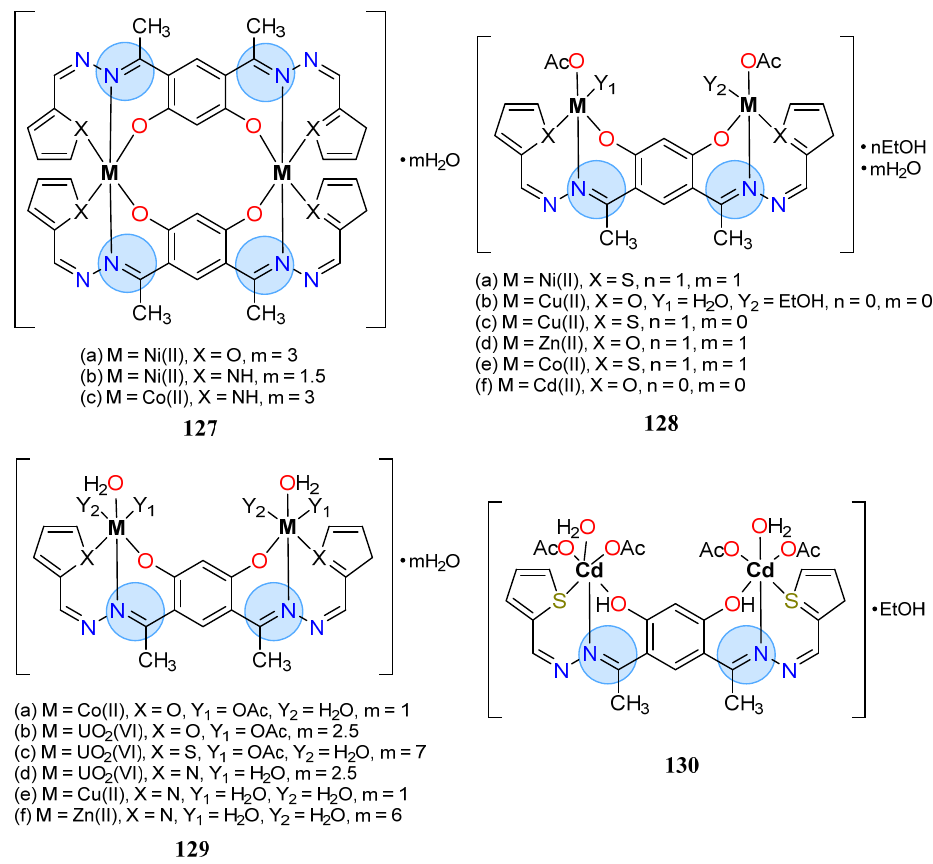
Figure 64. Dinuclear complexes with Schiff base ligands derived from hydrazones studied for their antimicrobial activity.